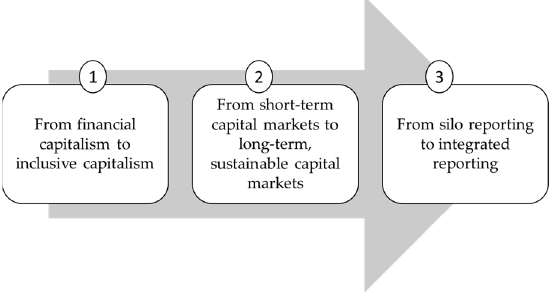
Figure 2. The Three Paradigm Shifts in Corporate Governance. Source: Institute of Directors (IoD) (2016).